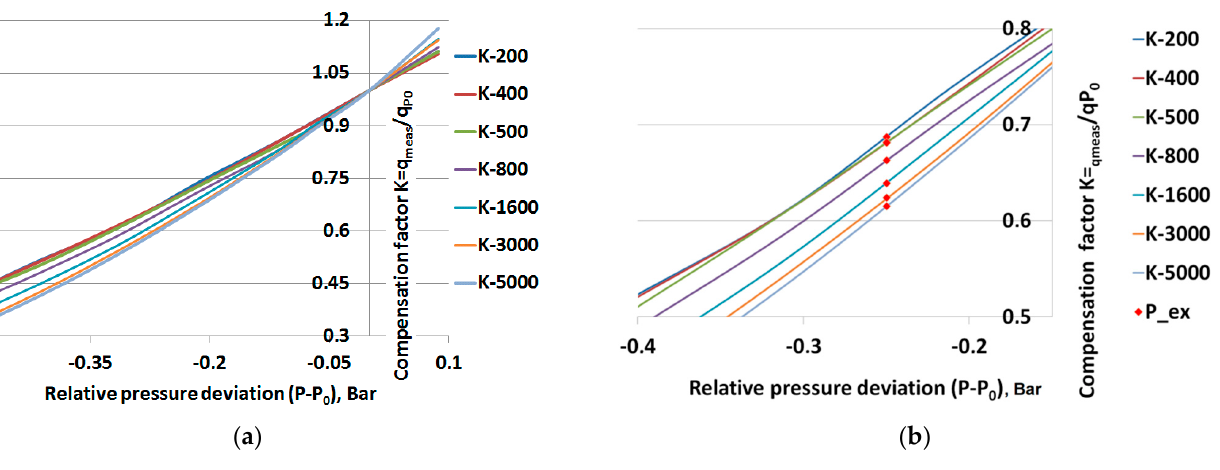
Figure 4. ( a ) Compensation factor K as function of relative pressure for different reference concen- trations (200, 400, 500, 800, 1600, 3000, and 5000 ppm), ( b ) magnification of the relative pressure range − 0.4 to − 0.15 Bar for visually enhancing the concentration dependence of the compensation factor—red dots show difference in compensation factor values for different concentrations at the same pressure level P_ex .